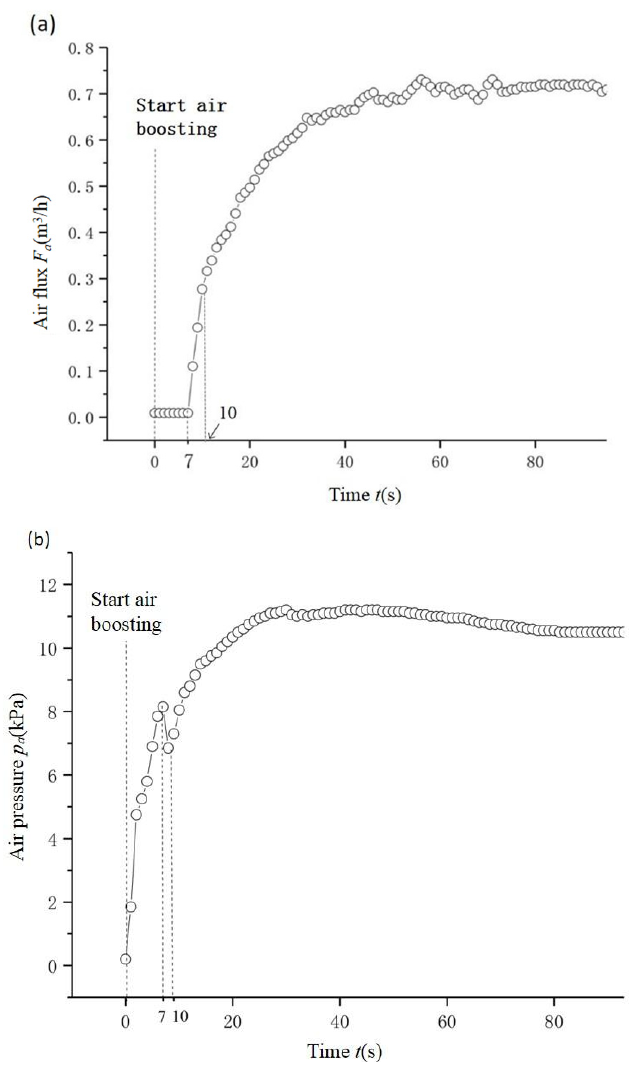
Figure 7. Time histories of boosted air: ( a ) air flux; ( b ) air pressure.